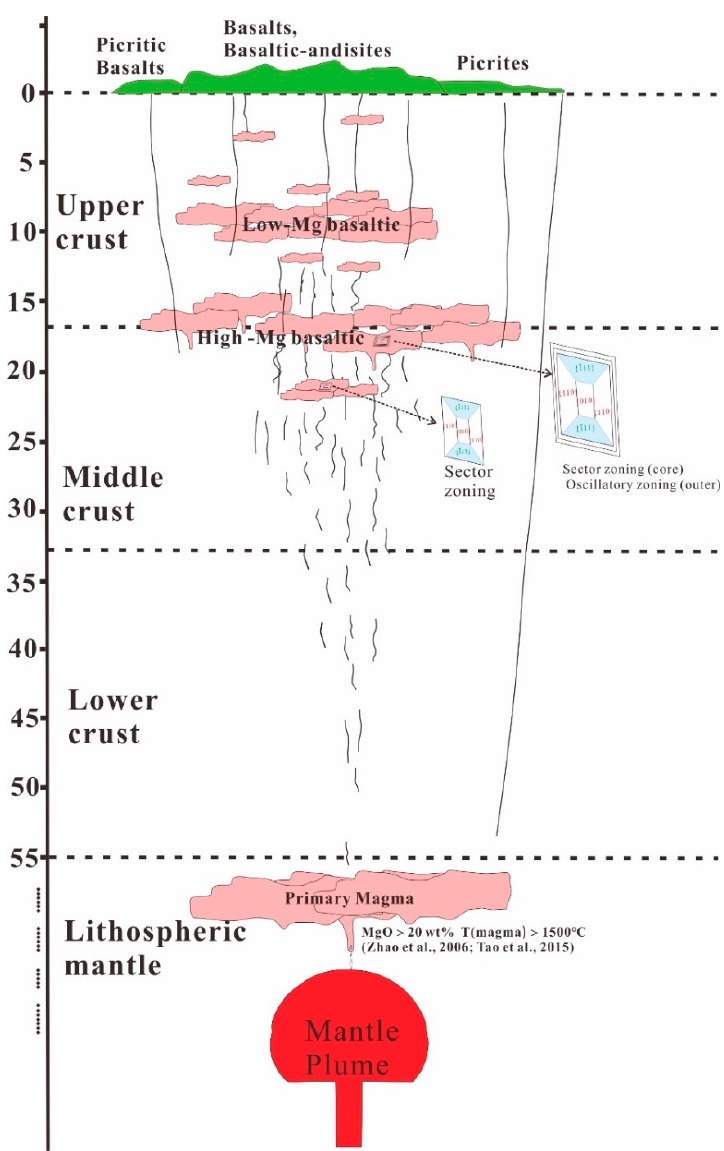
Figure 11. A schematic model of the magma plumbing system of the ELIP.